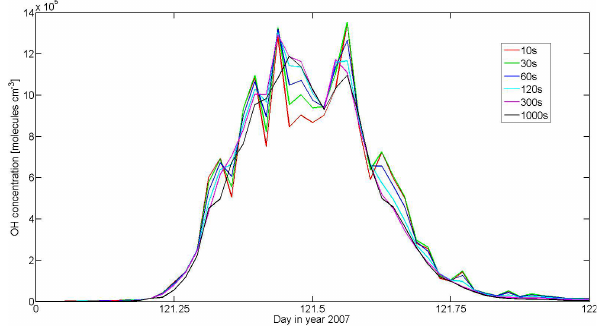
Fig. 1. Sensitivity studies for modelled OH-concentrations with dif- ferent